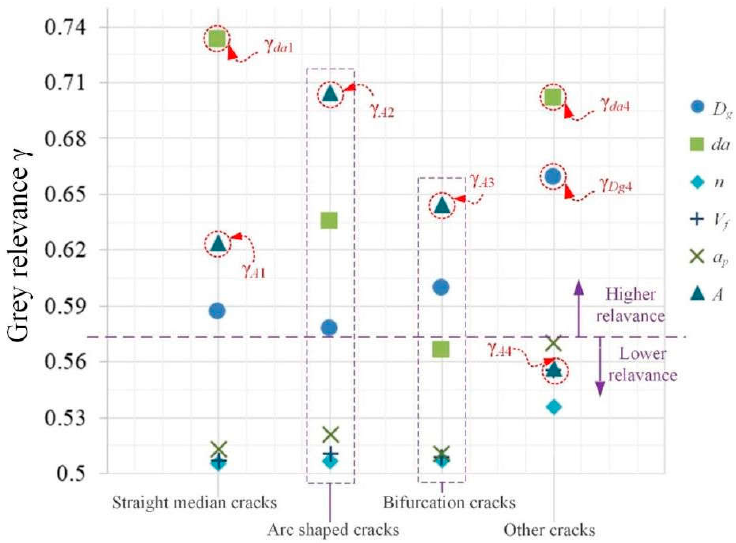
Figure 6. Relevance of process parameters to subsurface crack form distribution.